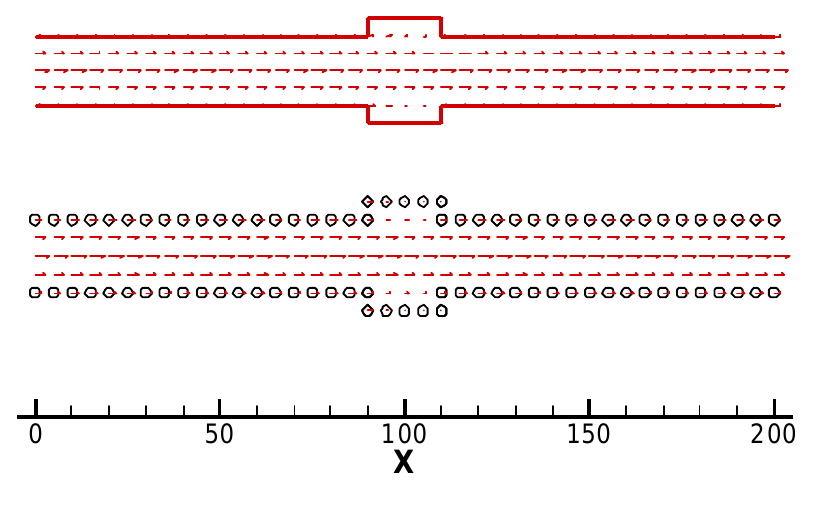
Figure 6. Velocity vectors by the MD simulation (with circle boundary) and the FEM (with solid line boundary) in Case